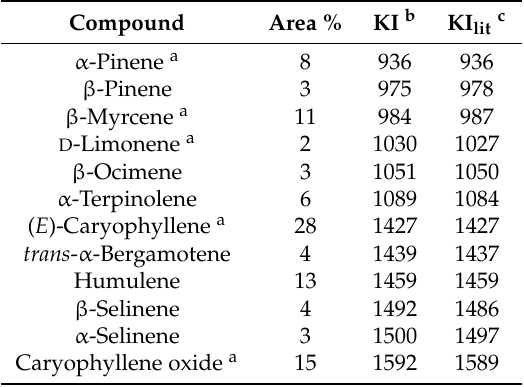
Table 2. Phytochemicals identified by GC/MS analysis of hemp